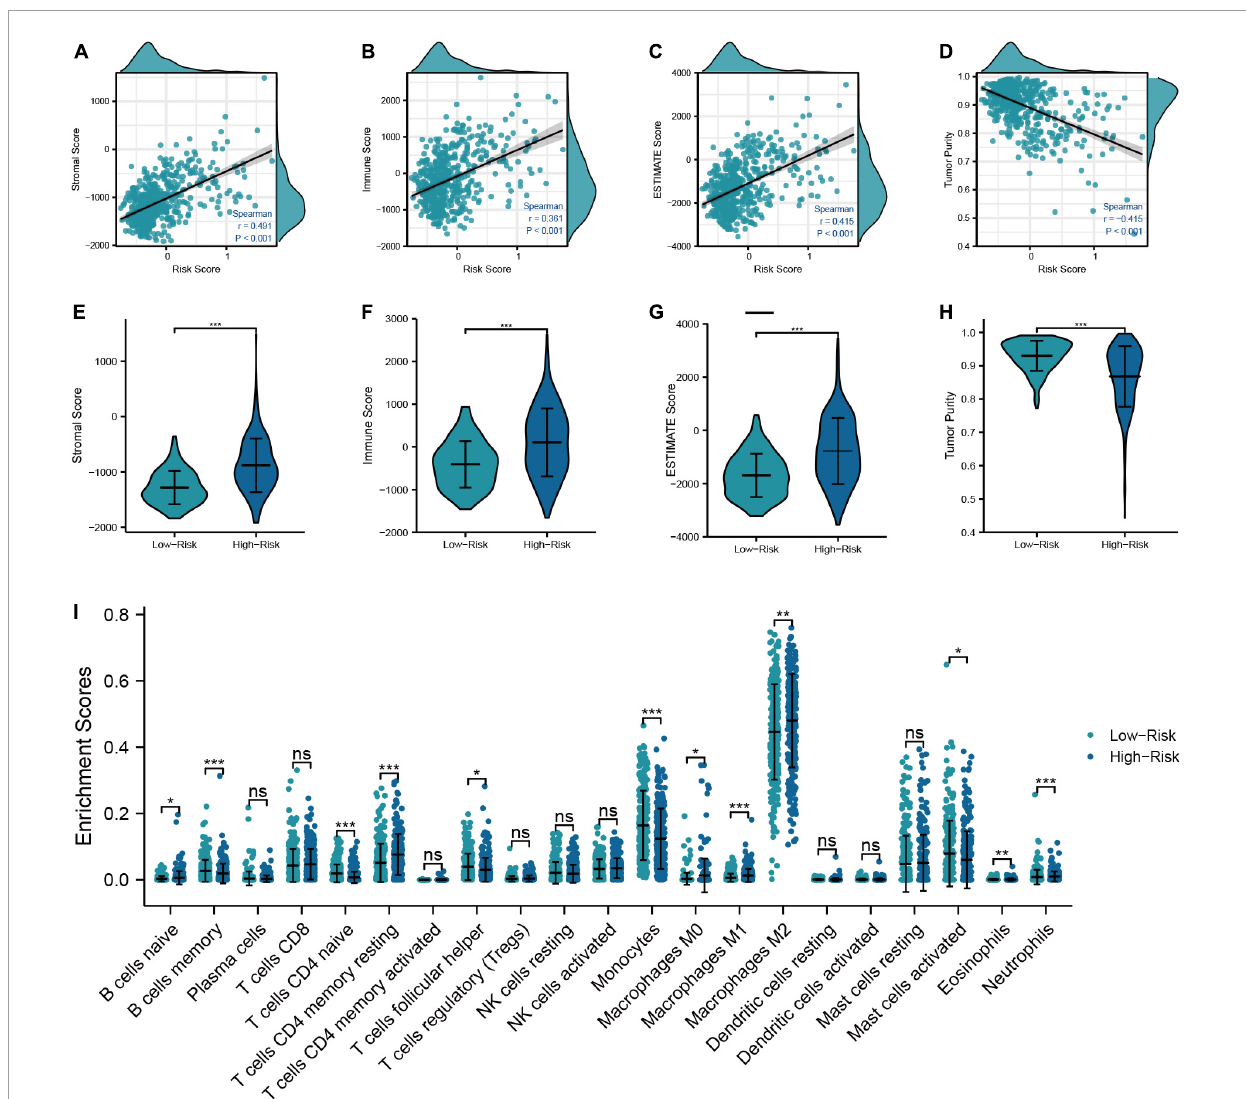
FIGURE5 Relationship between the risk model and TIME. (A–D) Correlation analysis of risk score with tumor microenvironment scores (Stromal score, immune score, ESTIMATE score, and tumor purity). (E–H) Comparison of tumor microenvironment scores between low- and high-risk groups. (I) Differences in the infiltration level of immune cells between risk groups (*** P < 0.001, ** P < 0.01, * P <